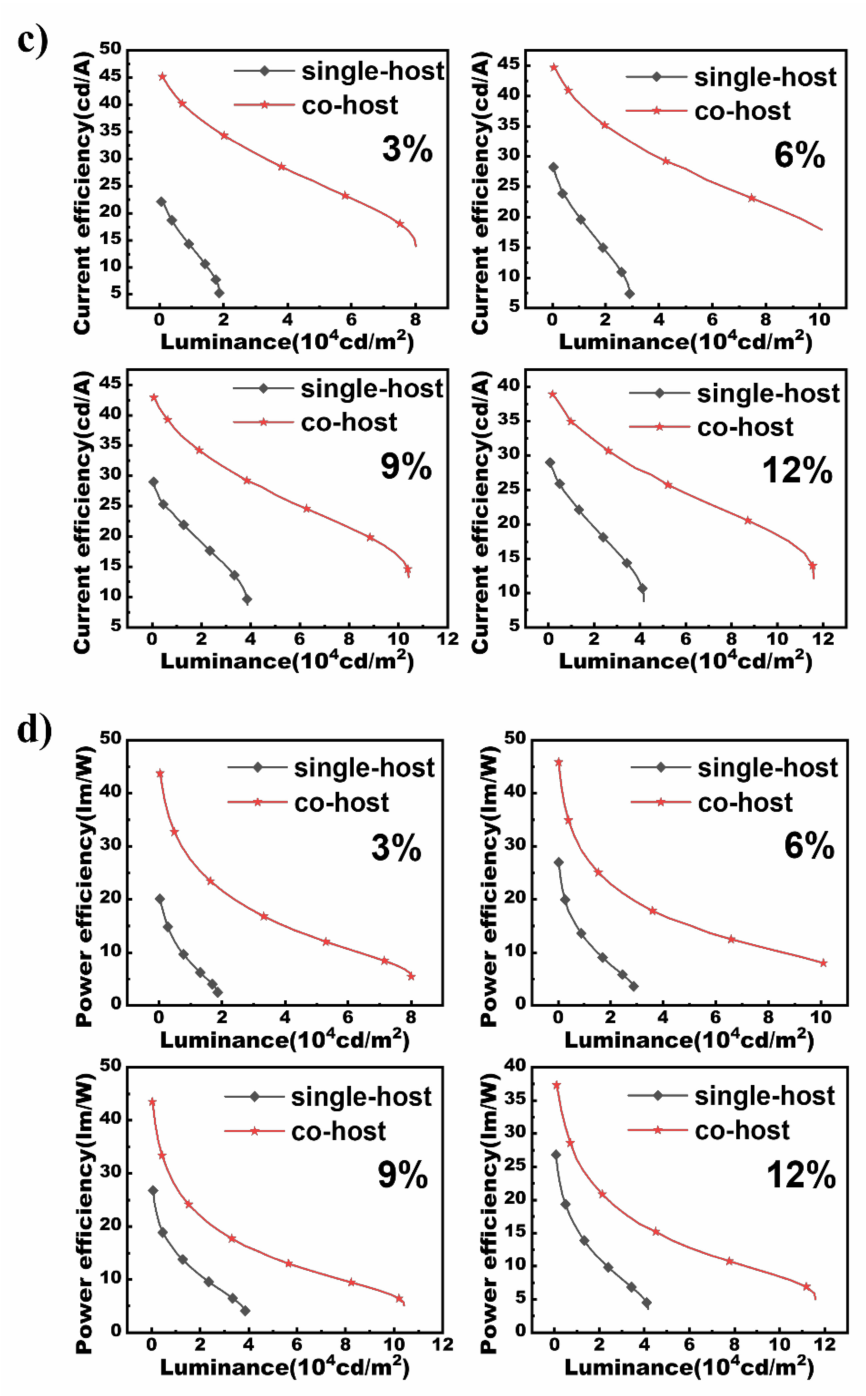
Figure 3. The current density-voltage ( a ), luminance-voltage ( b ), luminance-current efficiency ( c ), luminance-power efficiency ( d ) for the co-host and single-host